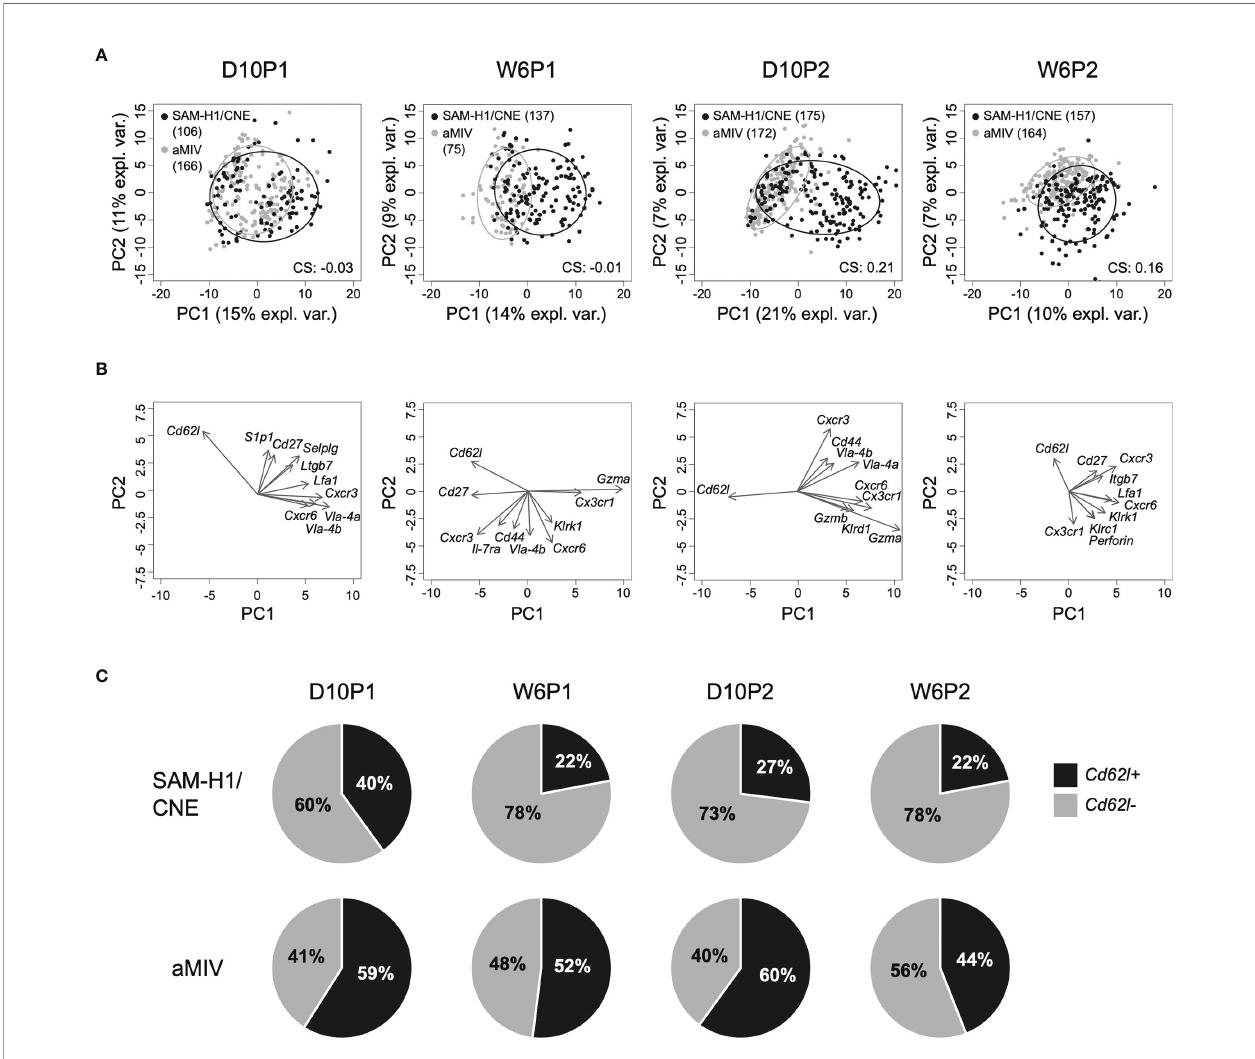
FIGURE 2 | PCA of the transcriptome pro fi les of pent+CD8+ T cells. (A) Kinetics of individual pent+CD8+ T cells induced by SAM-H1/CNE (black) and aMIV (grey) represented on the fi rst two principal components. CS: clustering score indicating the degree of cluster separation. (B) Loading plots representing the ten most informative genes across the different time points. (C) Relative proportion of Cd62l+ and Cd62l - pent+CD8+ T cells across treatments and time